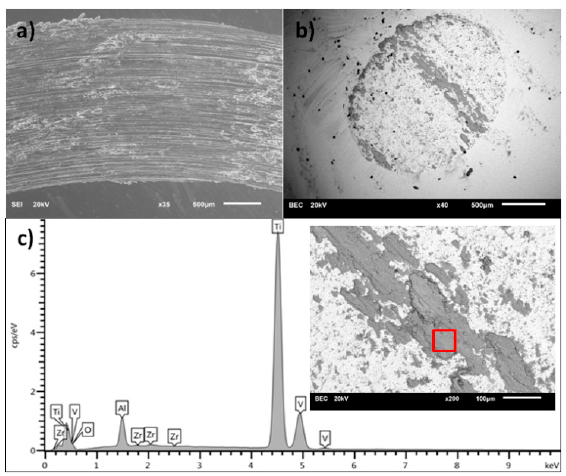
Figure 8. ( a ) Wear track on the surface of Ti-6Al-4V sample, ( b ) wear scar on the ZrO 2 ball surface, ( c ) the EDS analysis of the surface of ZrO 2 counterbody (inset with square shows the place of analysis).